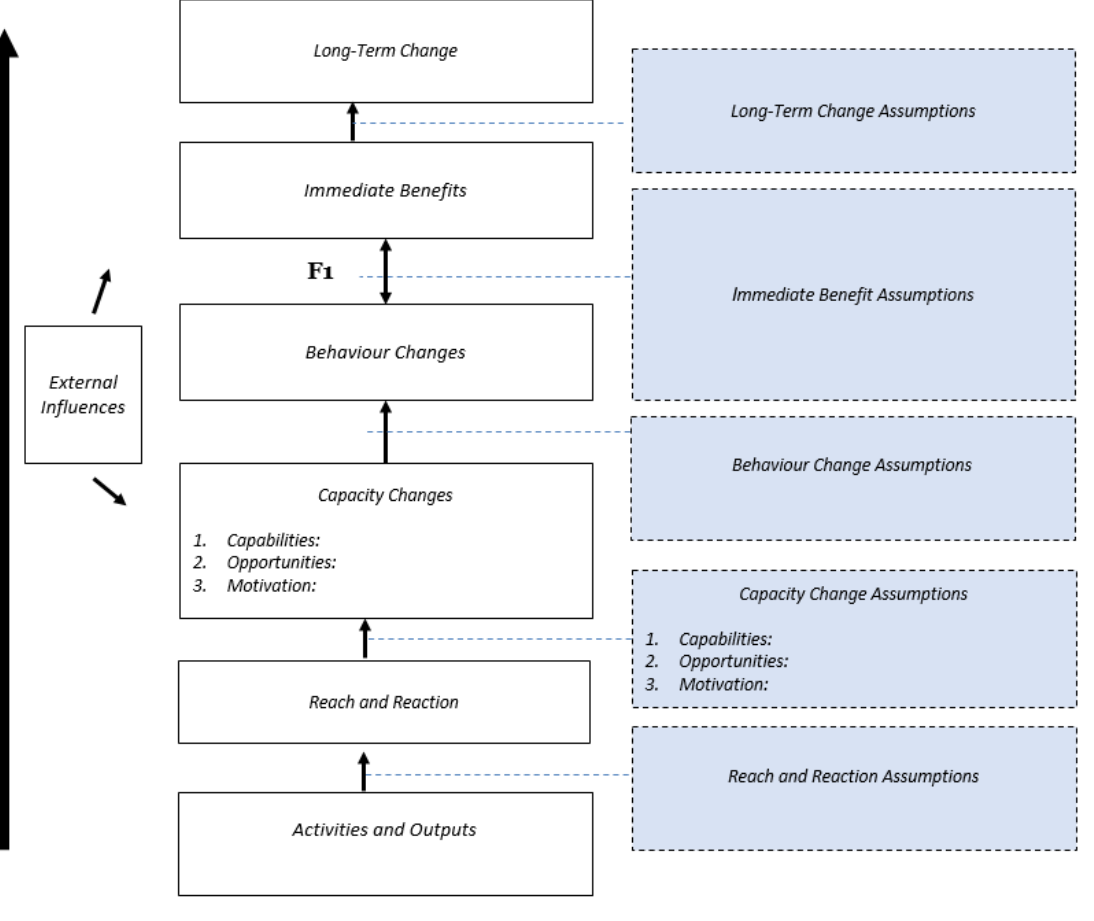
Figure 2: COM-B Theory of